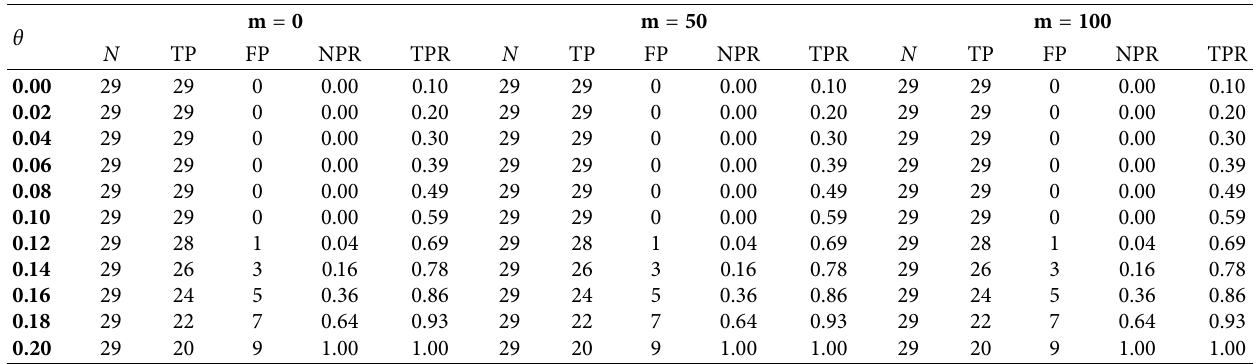
Table 4: Dataset of the ROC curve comparing model BCT and B